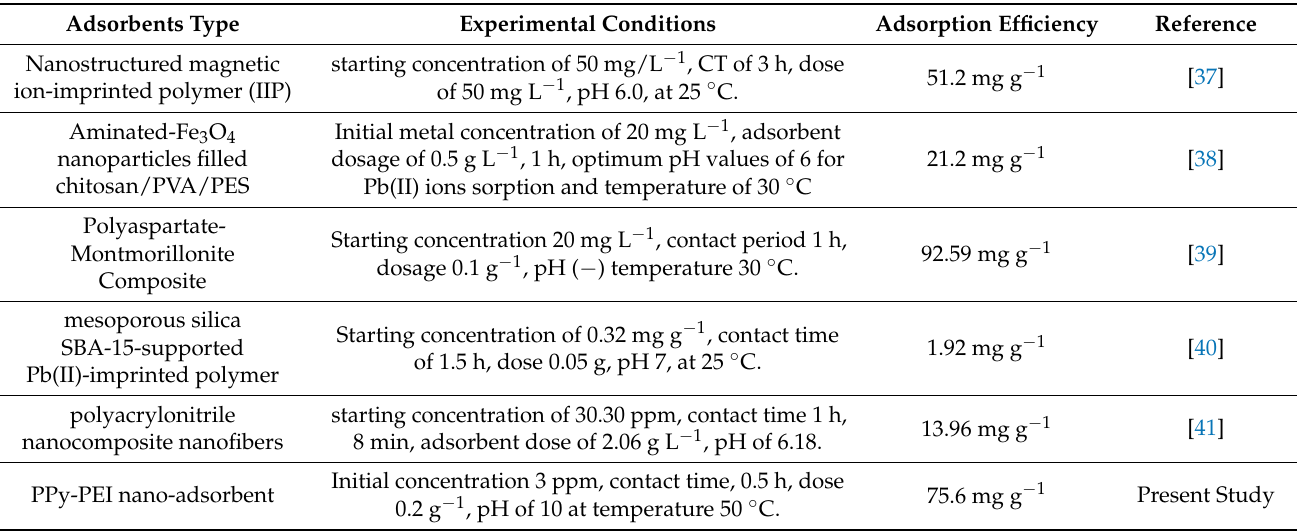
Table 6. The effectiveness of polymer-based compounds for adsorbing lead